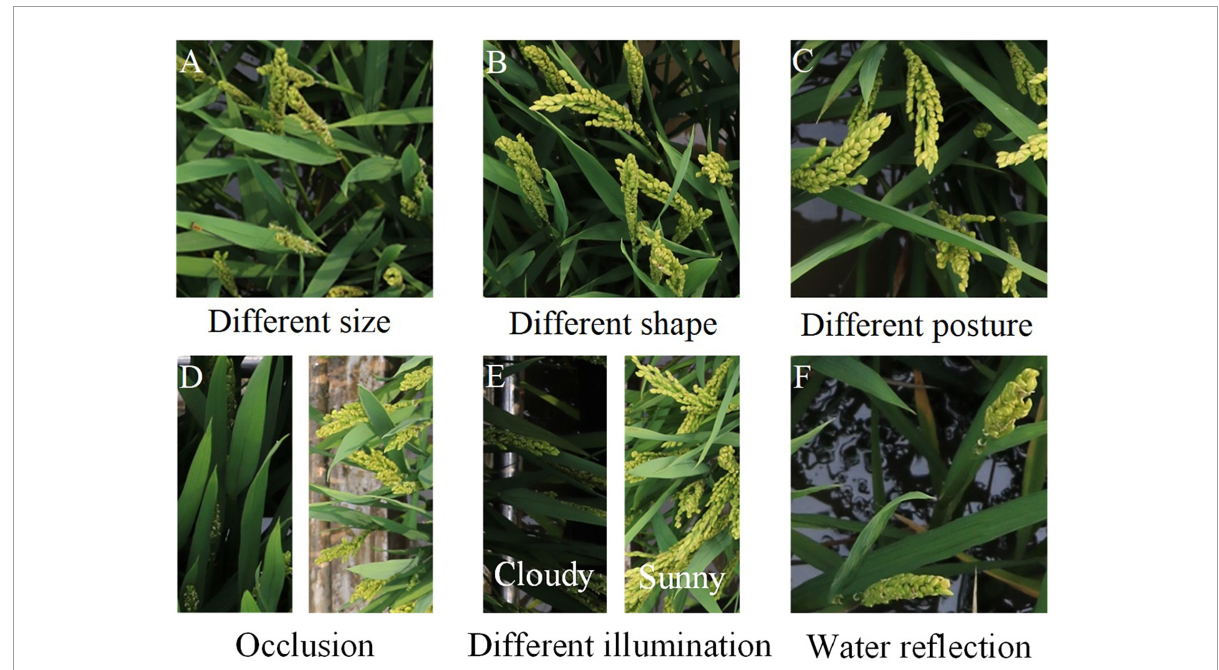
FIGURE1 Challenges in rice panicle detection. (A) Different size. (B) Different shape. (C) Different posture. (D) Occlusion. (E) Different illumination. (F) Water